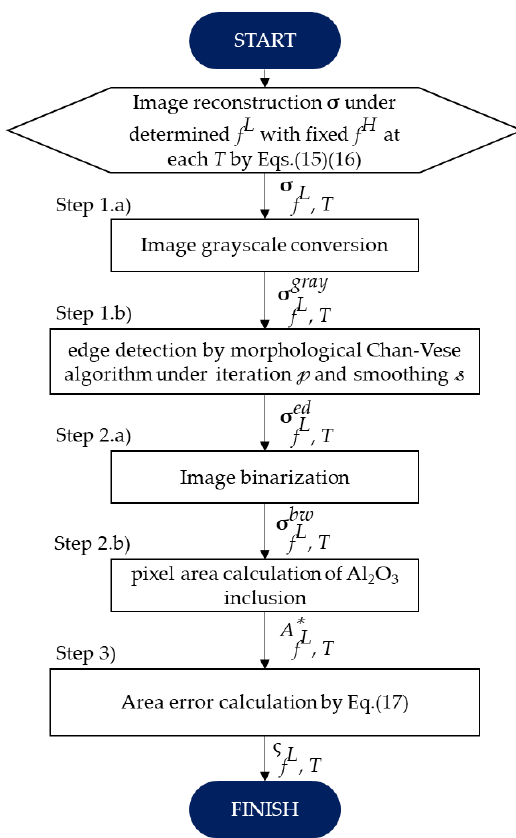
Figure 13. Image binarization.